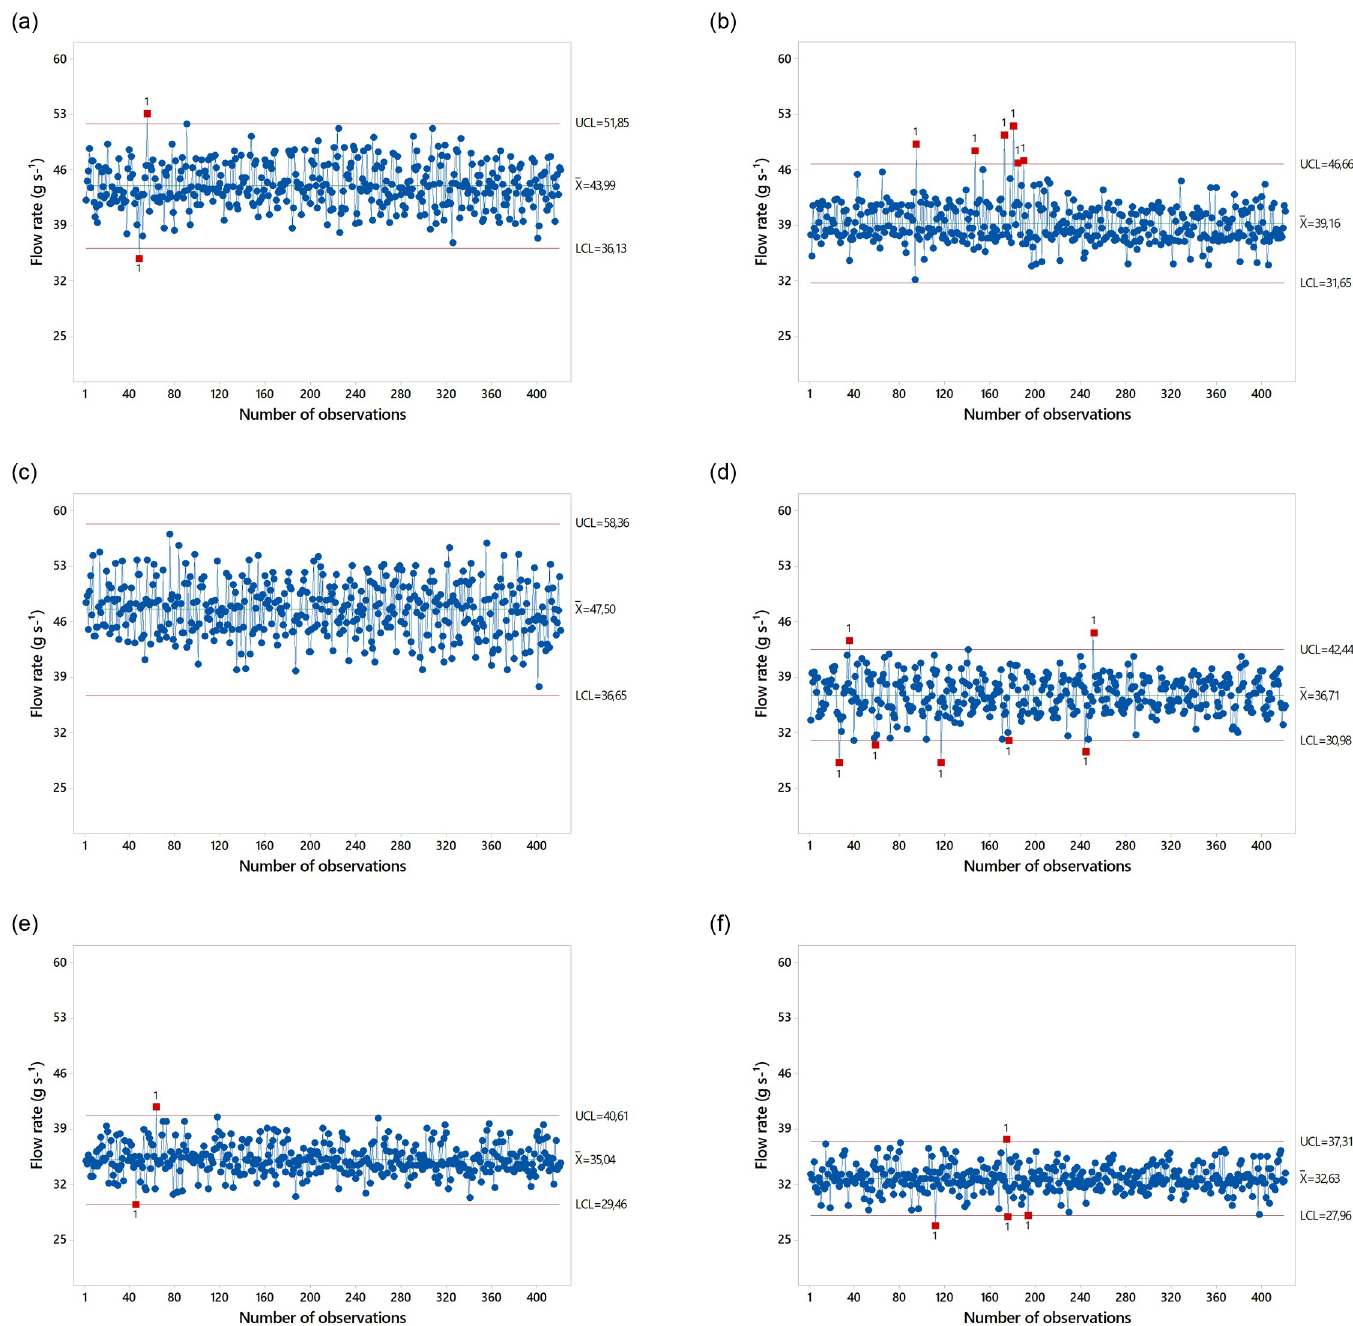
Fig 6. Performance of fertilizer spreaders at a speed of 2.77 m s -1 .